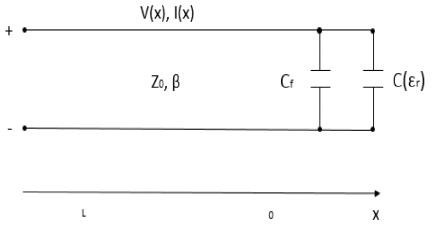
Figure 8. Electrical equivalent circuit of a coaxial probe and dielectric sample according to the capacitive model.